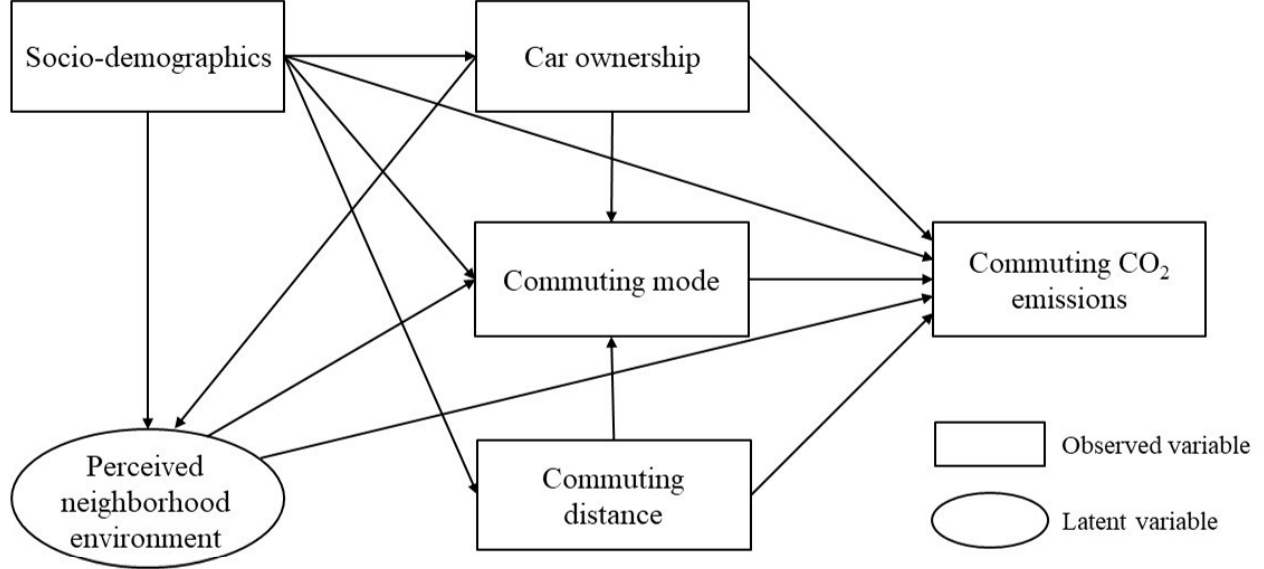
Figure 2. Conceptual framework for the structural equation model.